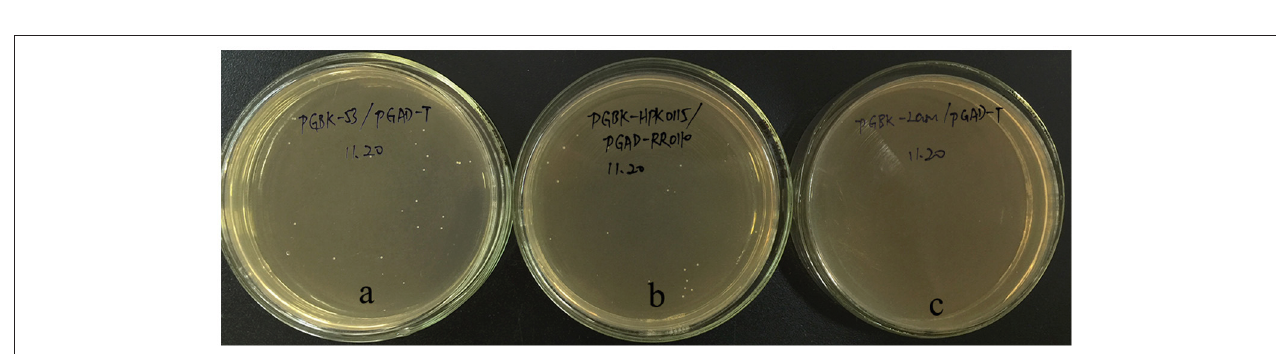
FIGURE 11 | WP_011677872.1 and WP_011677871.1 interaction in a yeast two-hybrid assay. (a) pGBKT7-53/pGADT7-T; (b) pGBK-HPK0115/pGAD-RR0110; (c) pGBKT7-Lam/pGADT7-T.